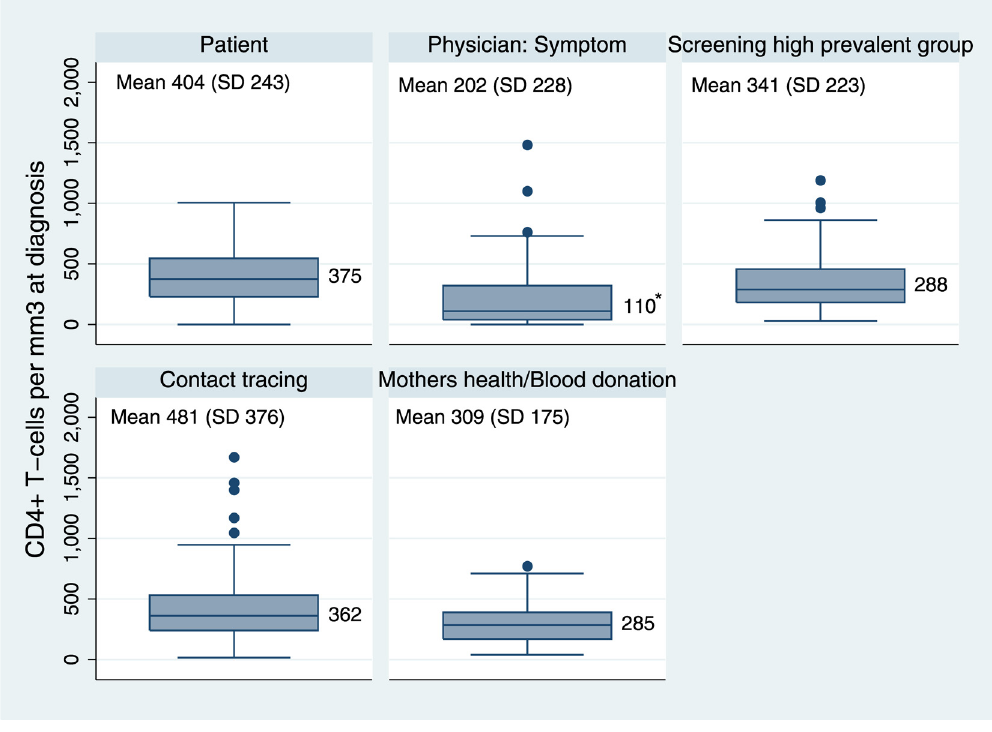
Fig 3. CD4+ T-cell count at diagnosis, depending on the initiator of/reason for HIV-testing. * The Kruskal Wallis test shows significant differences in median CD4 count between physician as initiator of the test and all other